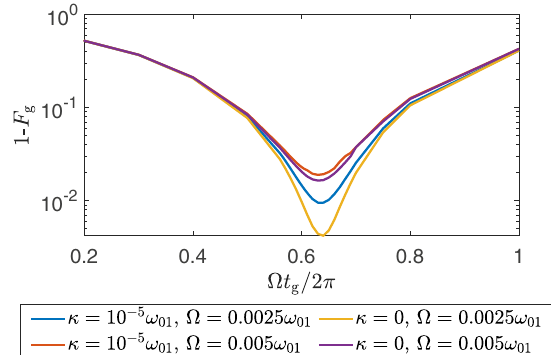
¼ t g þ 2 t r and we g